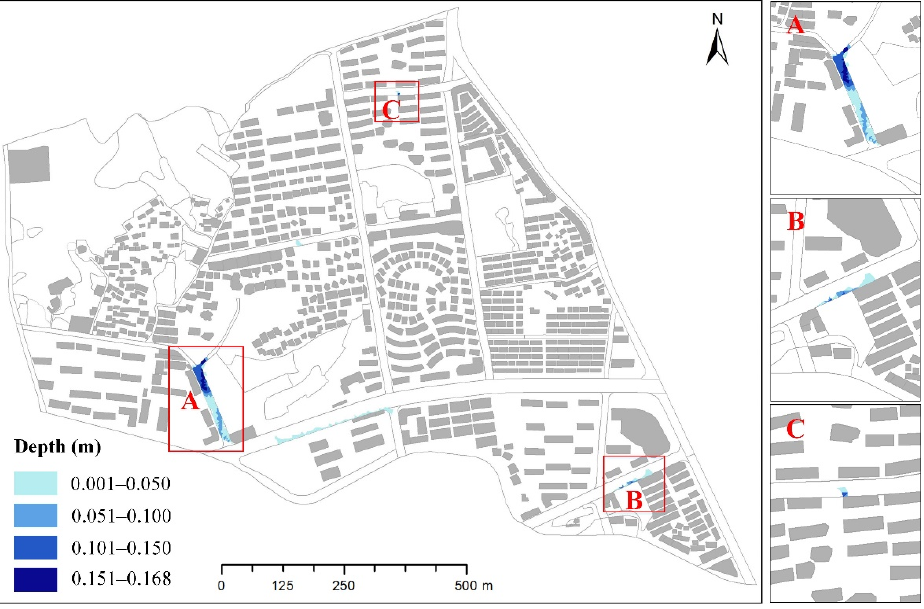
Figure 8. The inundation result from rainfall on 2 July 2020 (( A ) is MXR, ( B ) is XSS, and ( C ) is SLS).